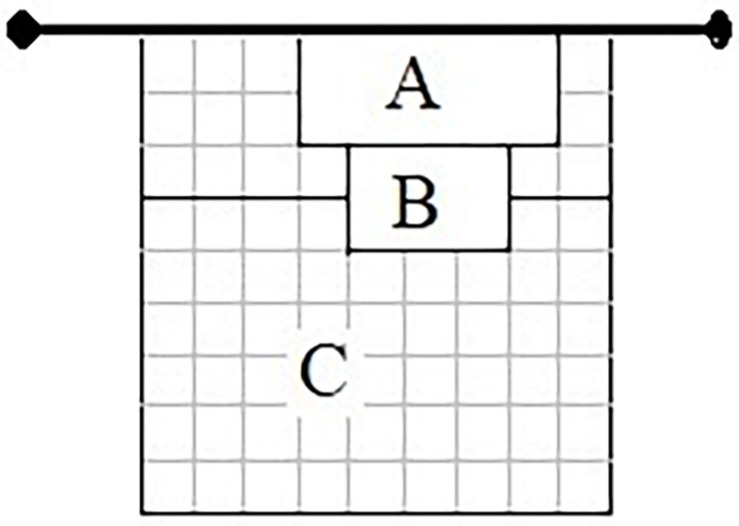
Setting zone (Adapted from Castro and Mesquita, 2010, p. 200).